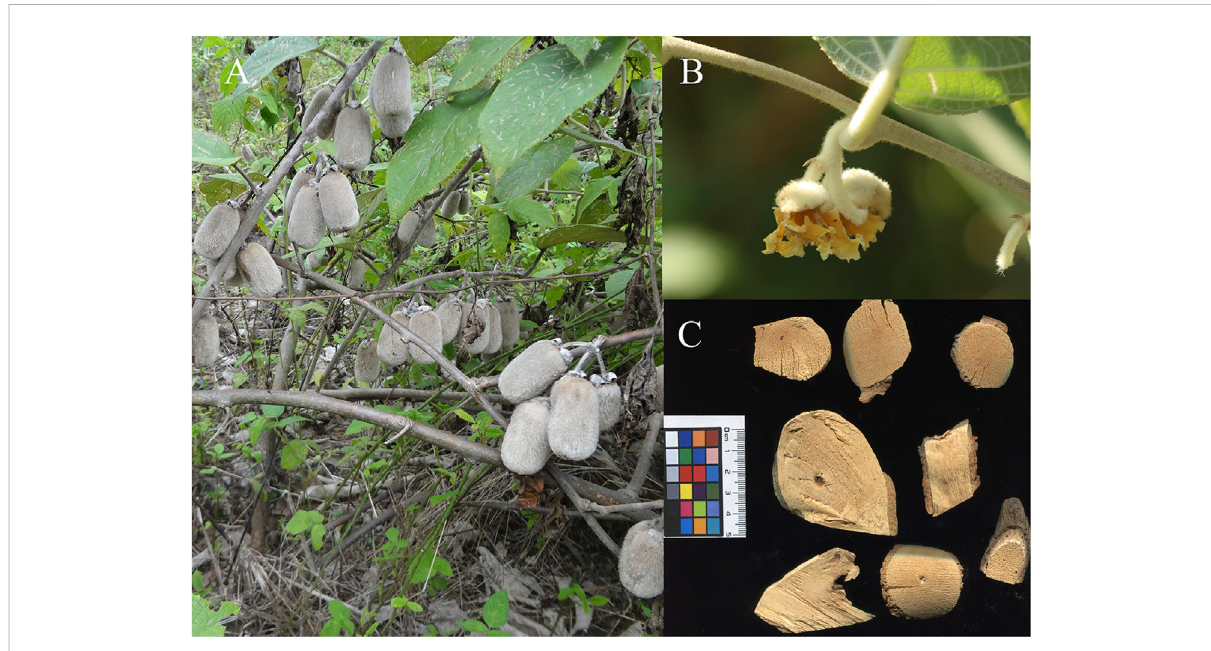
FIGURE 1 The whole plant (A) , fl ower portion (B) , and commercial herbal root pieces (C) of A.